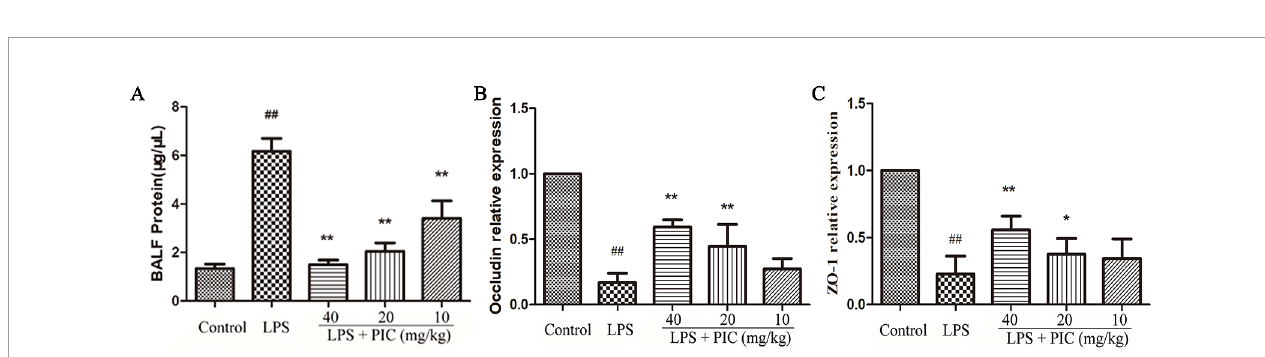
FIGURE 9 | The evaluation of air-blood barrier permeability. (A) The total protein of bronchoalveolar lavage fl uid (BALF) were measured by the bicinchoninic acid assay (BCA) kits to assess epithelial permeability. The messenger RNA (mRNA) expression of (B) occludin and (C) ZO-1 was tested using quantitative real-time (qRT)-PCR. ## p < 0.01 is signi fi cantly different from the control group; * p < 0.05 and ** p < 0.01 are signi fi cantly different from the lipopolysaccharide (LPS)